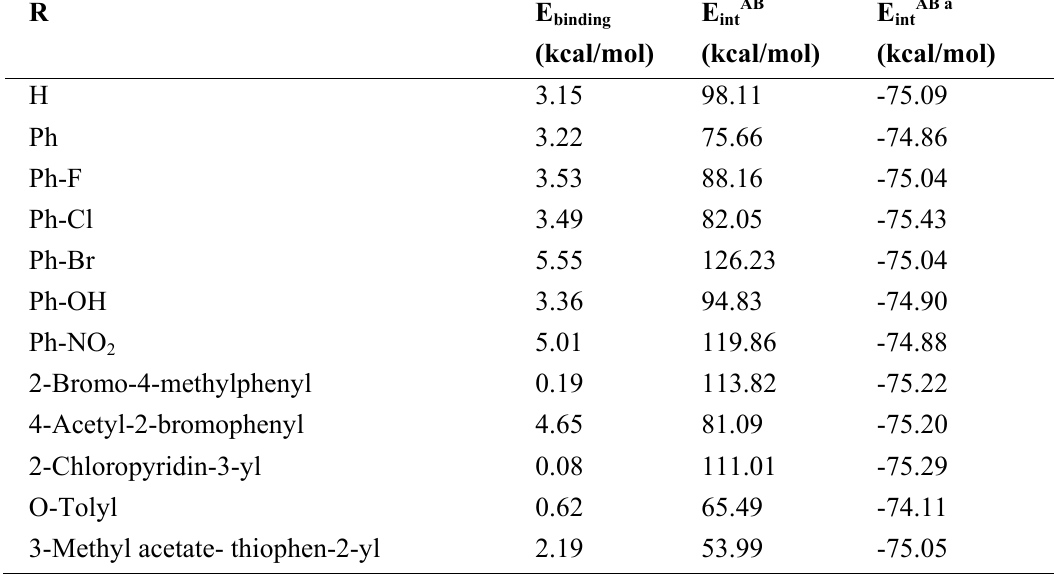
Table 1. Binding energies and E intAB of TTAs-copolymer systems calculated and E intAB of TTAs- coploymer systems with tyrosine calculated by ONIOM2